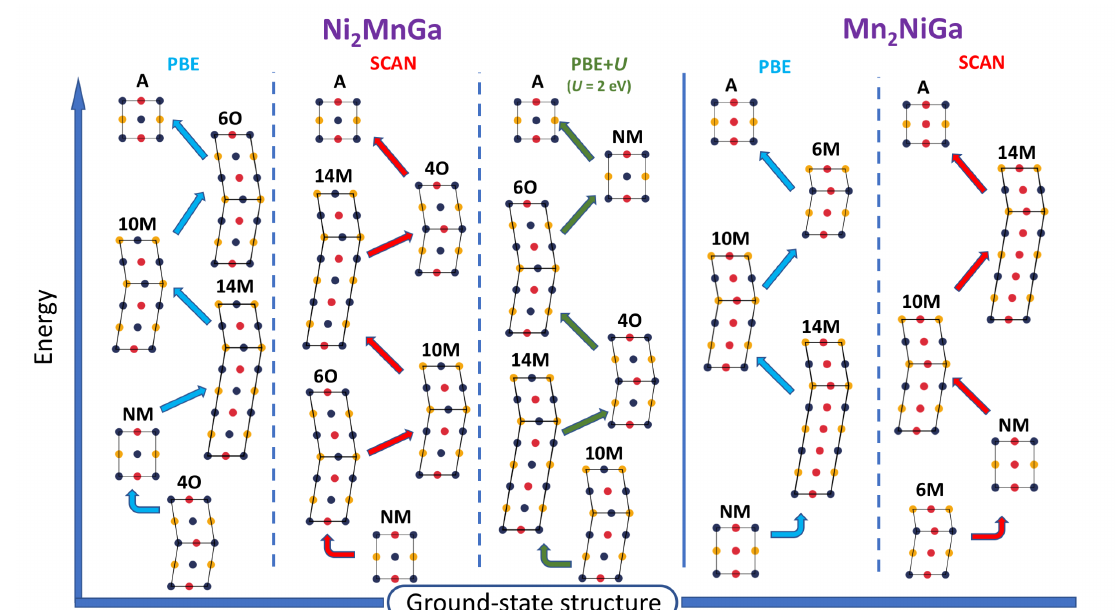
Figure 8. The predicted sequences of phase transitions in Ni 2 MnGa [109] and Mn 2 NiGa [110] by the GGA PBE, SCAN, and GGA + U schemes with the corresponding crystal structures. Here, blue circles are Ni atoms, red circles are Mn atoms, and orange circles are Ga atoms. The experimental ground state for Ni 2 MnGa is the 10M structure, while the sequence of 10M → 14M → NM transformations is observed only for off-stoichiometric alloys with Mn excess above 3 at.% or under tensile stress [109]. The martensitic structure of Mn 2 NiGa is reported to be NM [124], 7M [125], and 14M